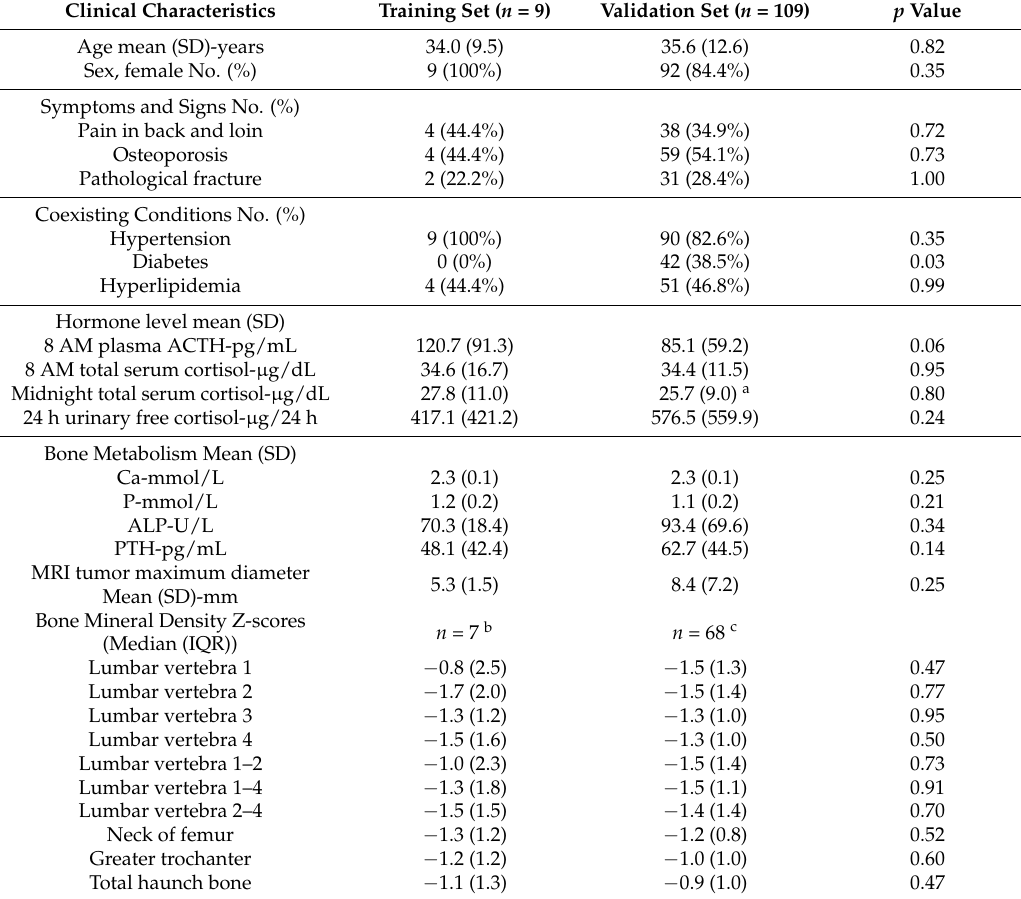
Table 1. Clinical characteristics of 118 Adrenocorticotrophin (ACTH)-secreting pituitary adenomas